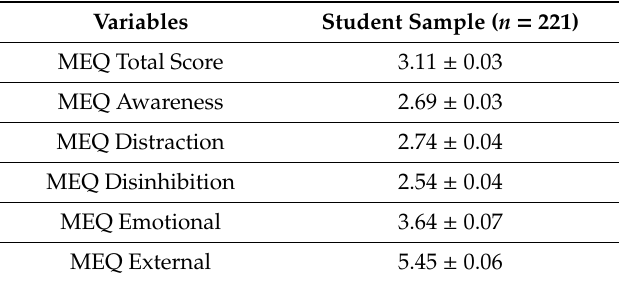
Table 2. Mindful Eating Questionnaire (MEQ) total score and subscales for university students.